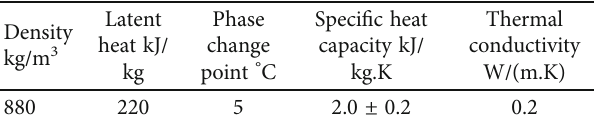
Table 1: Thermo-physical characteristics of the